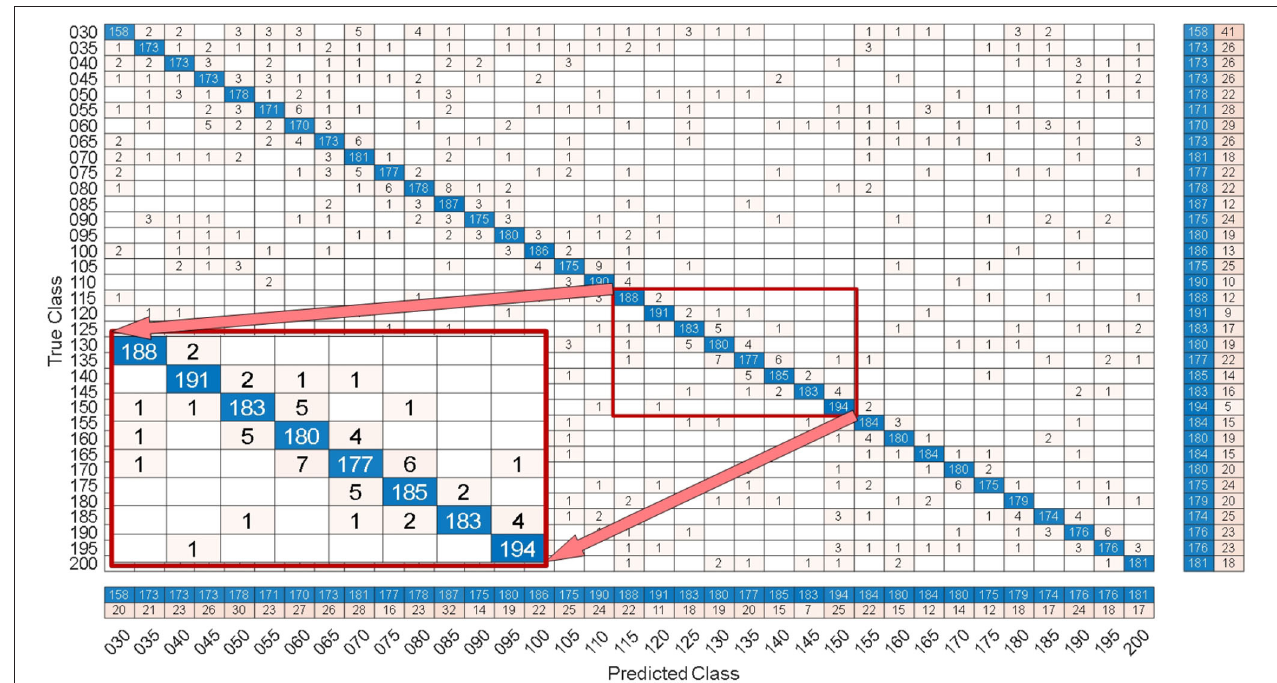
FIGURE 8 | Under the 0.7 s time window, the confusion matrix of one of the 10-fold cross validation of the SSMVEP dataset.